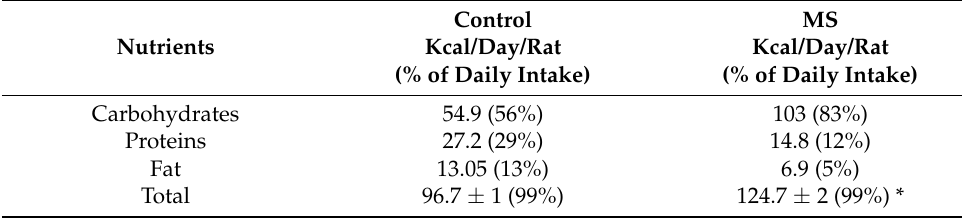
Table 1. Daily caloric intake and nutrimental distribution. Nutrients